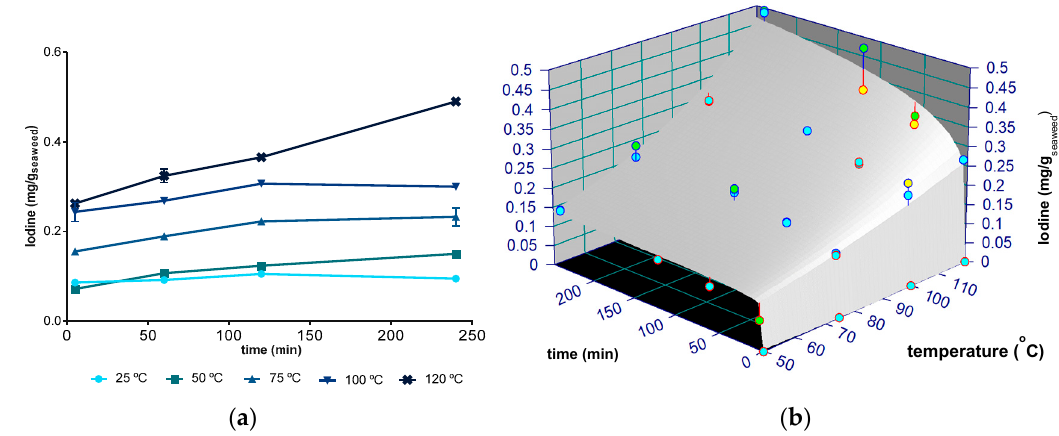
Figure 3. ( a ) Amount of iodine (mg/g of dried seaweed) extracted at 25, 50, 75, 100, and 120 °C and between 5 minutes and 4 hours; ( b ) Fitting plot of power law with Arrhenius dependence to the iodine extract at 50, 75, 100, and 120 °C during 5 min to 4 h (240 min) (blue, green, and yellow, identify, respectively, 1, 2, and 3 standard deviations).